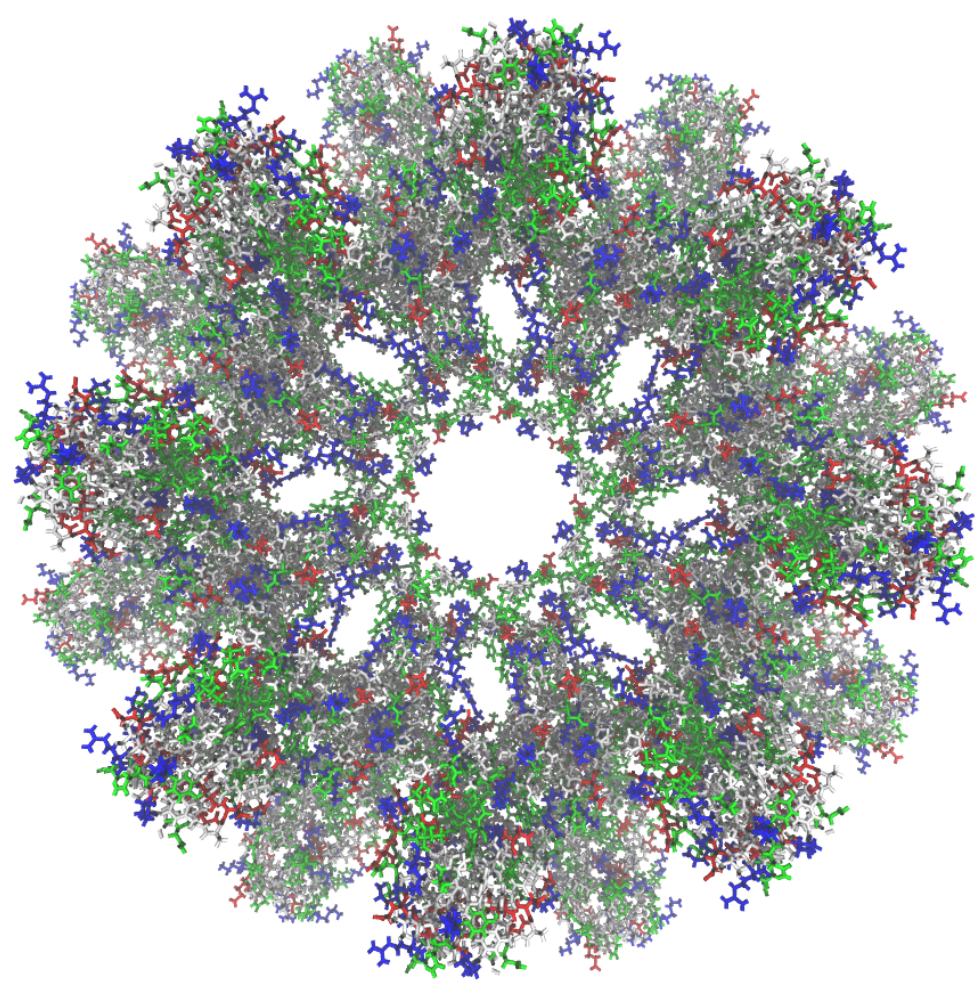
Figure 4. 4V4L molecular structure from Protein Data Bank. The image has been generated using VMD